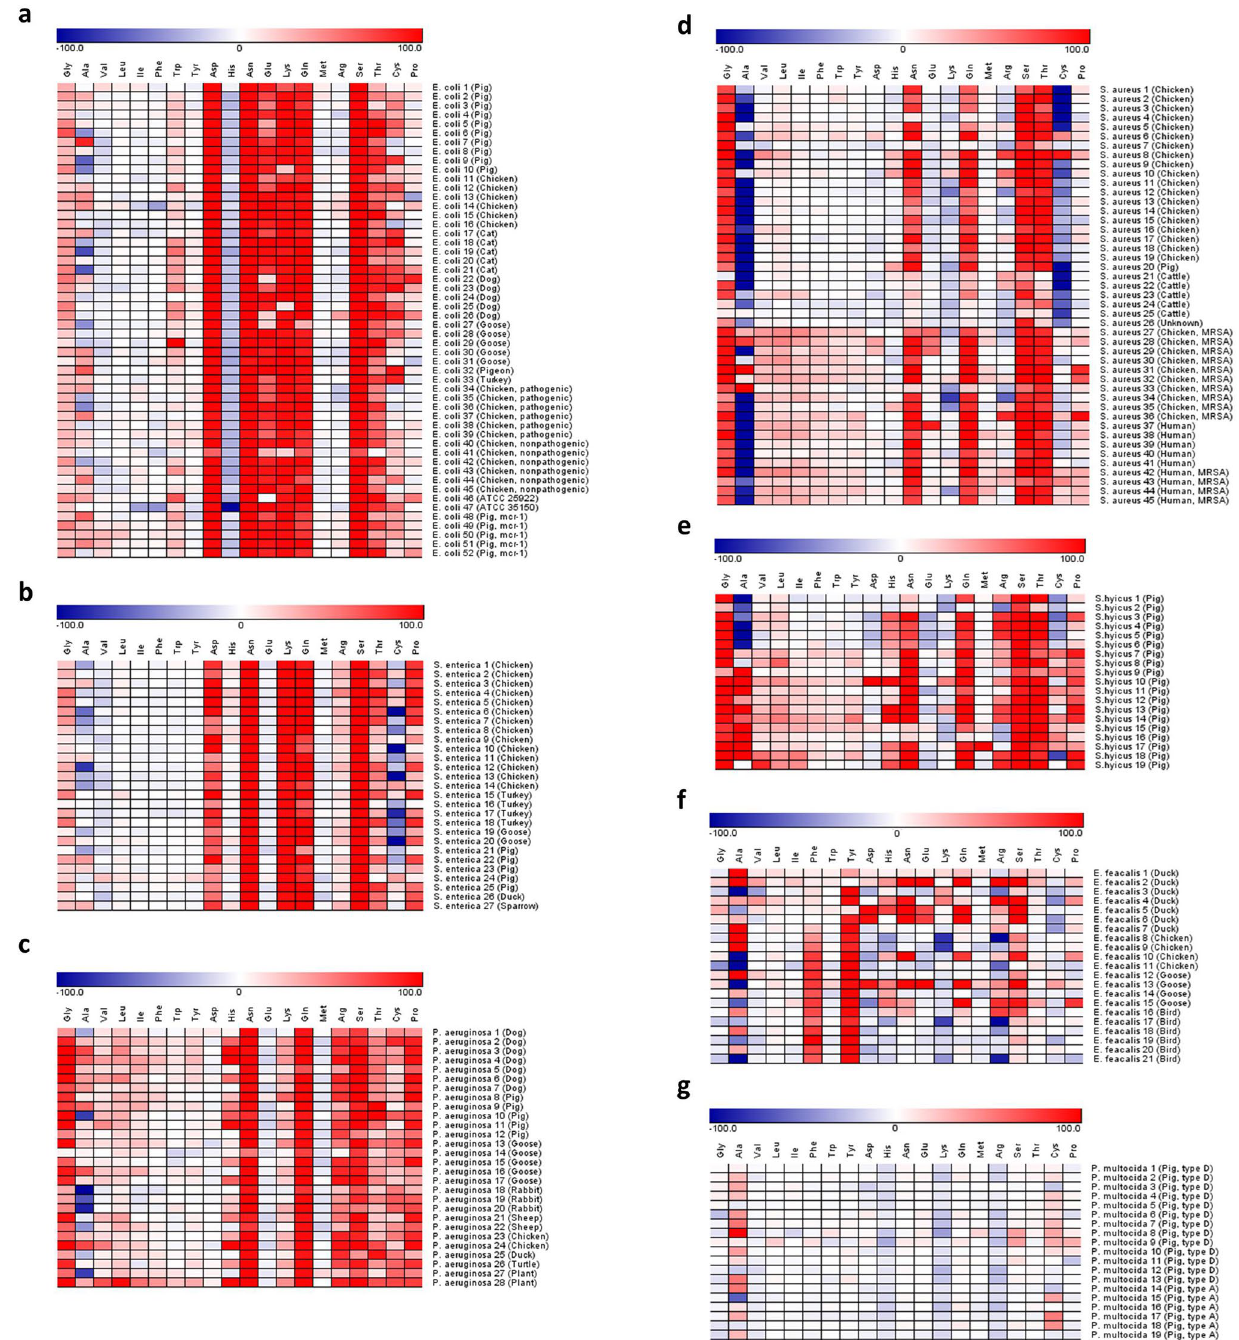
Figure 1. Heat map showing AA consumption profiles of 7 bacterial species. The heat map shows the consumption of 20 AAs by 213 strains from 7 bacterial species including ( a ) E. coli , ( b ) S. enterica , ( c ) P. aeruginosa , ( d ) S. aureus , ( e ) S. hyicus , ( f ) E. faecalis , and ( g ) P. multocida . The color gradients, which goes from white to red and white to blue, represent the level of positive consumption (0–100%) and negative consumption (0 to -100%) of AAs,